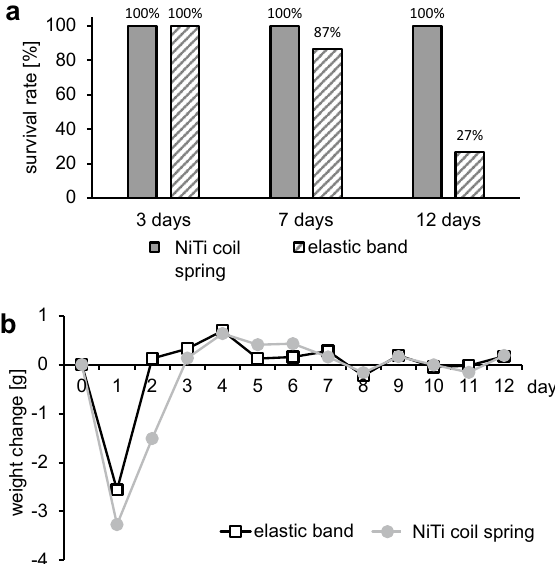
Figure 1. ( a ) Survival rate of the respective orthodontic appliance at the end of each treatment period (3, 7 and 12 days). ( b ) Daily weight change of the animals across the experimental